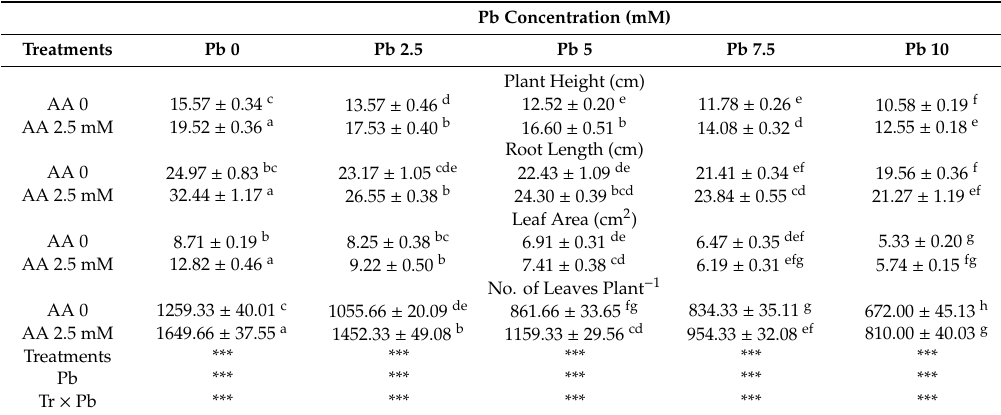
Table 2. E ff ect of Pb (0, 2.5, 5, 7.5 and 10 mM) with and without AA (2.5 mM) on growth parameters of A. bettzickiana